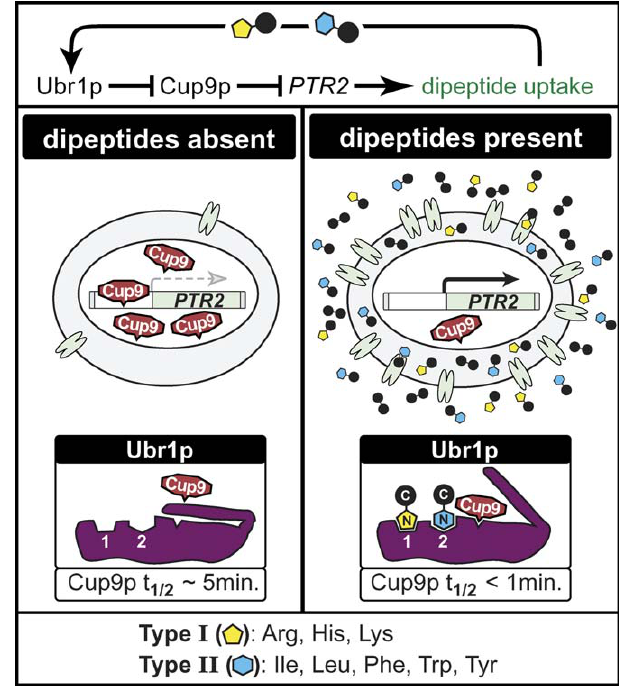
Figure 1. Di/Tripeptide Uptake Is Enhanced by a Positive Feedback Loop Governed by the N-End Rule Pathway The E3 ubiquitin ligase Ubr1p contains binding sites for proteins containing Type 1 (Arg, His, and Lys) and Type 2 (Ile, Leu, Phe, Trp, and Tyr) N-terminal amino acids. In the absence of di/tripeptides, the PTR2 repressor Cup9p is abundant and PTR2 expression is minimal. Upon binding of Type 1 and/or Type 2 di/tripeptides to Ubr1p, an auto- inhibitory domain blocking the recognition of an internal Cup9p degron dissociates from the Cup9p binding site, decreasing the half-life of Cup9p (t ½ ) from approximately 5 min to less than 1 min. Consequently, PTR2 repression is relieved and elevated levels of Ptr2p enhance di/ tripeptide uptake, initiating a positive feedback loop. This figure was adapted from the diagram of Turner et al. [33], with the authors’